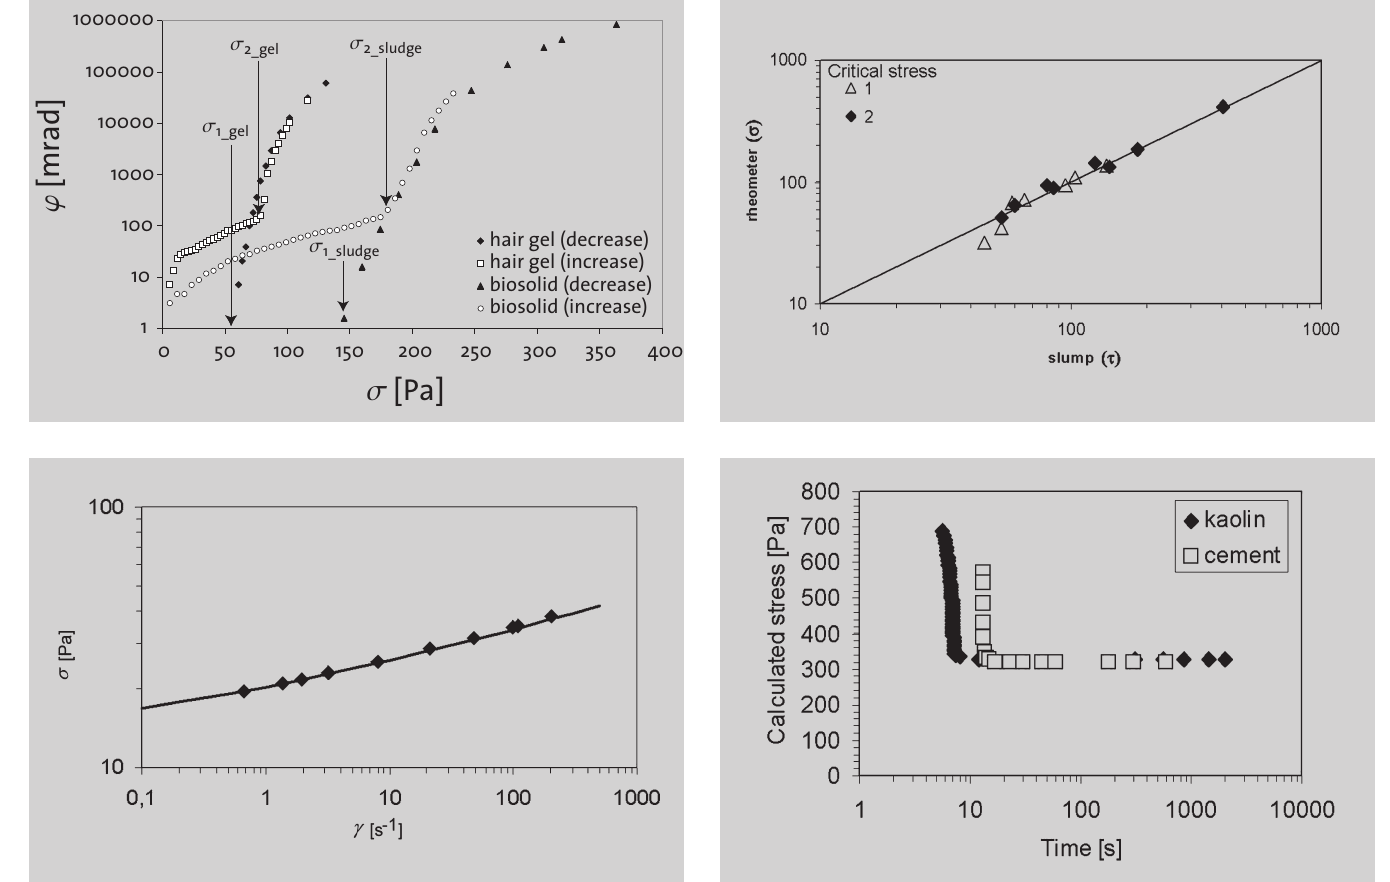
Figure 8 (left above): Hair gel and sewage sludge: angle of rotation as a function of stress during creep tests with successively increasing and decreasing stress ramps (see text), with an emphasis on particular points indicating behavior transitions (see text). Figure 9 (right above): Critical stresses obtained for the hair gel and different sewages sludges as obtained from rheometry and slump tests: t 1 a nd s 1 (in white), t 2 and s 2 (in dark). Figure 10 (left below): Kaolin suspensions (solid fraction: 20%): shear stress as a function of shear rate in steady state during controlled rate tests. Figure 11 (right below): Calculated stress from slump test as a function of time for a kaolin suspension and a cement